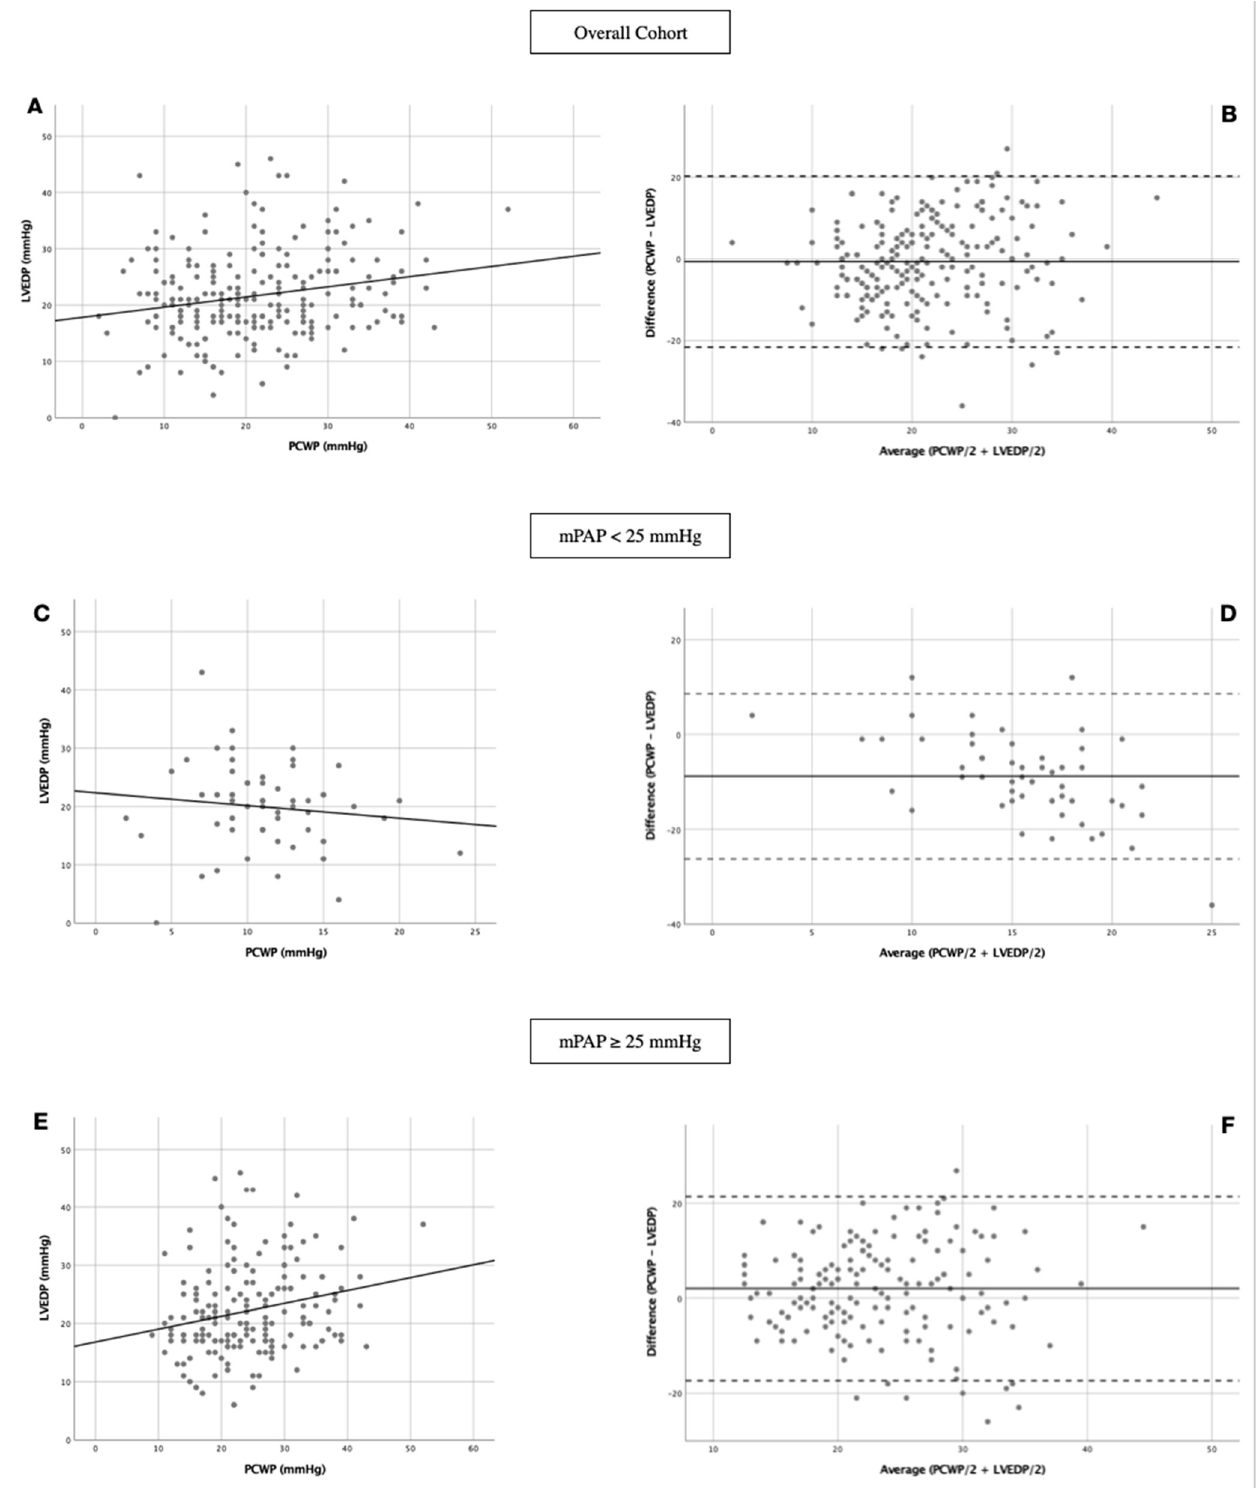
Figure 3. Linear regression and Bland-Altman analysis between PCWP and LVEDP. ( A ) Linear regression in overall cohort; ( B ) Bland-Altman analysis in overall cohort; ( C ) Linear regression in No PH patients; ( D ) Bland-Altman analysis in No PH patients; ( E ) Linear regression in PH patients; ( F ) Bland-Altman analysis in PH patients. LVEDP: left ventricular end-diastolic pressure; PCWP: pulmonary capillary wedge pressure; mPAP: mean pulmonary arterial pressure.